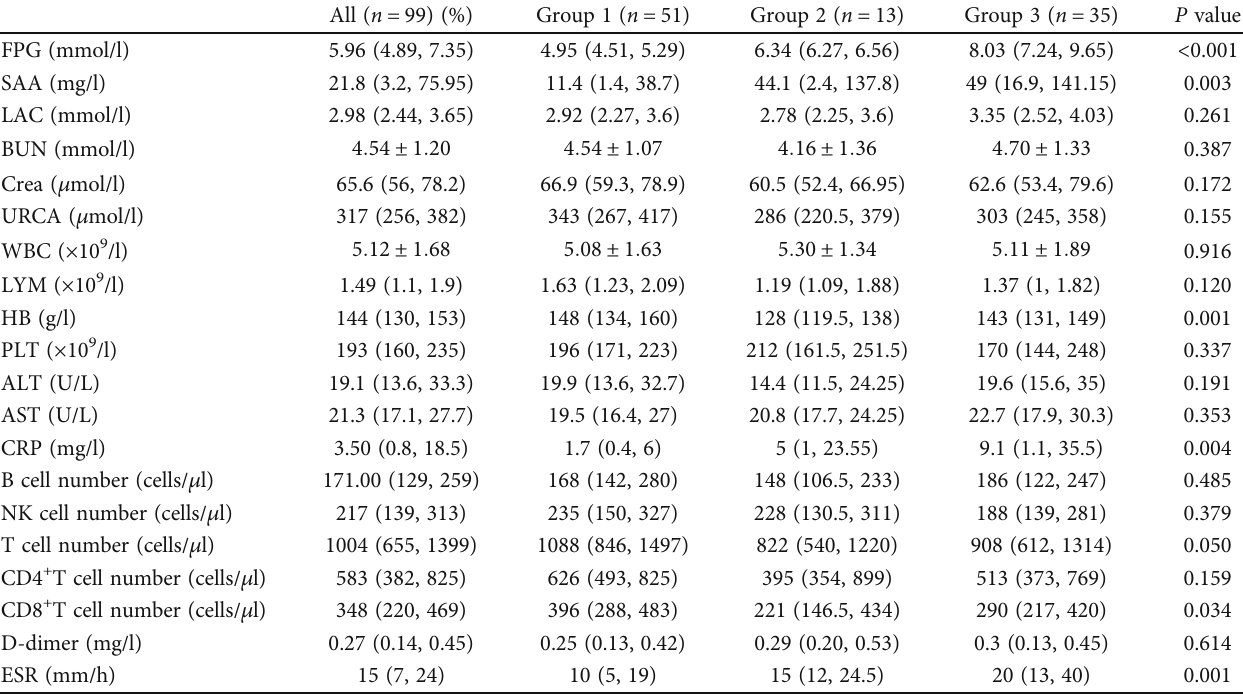
Table 2: Laboratory examination of COVID-19 patients at admission according to di ff erent FPG levels.